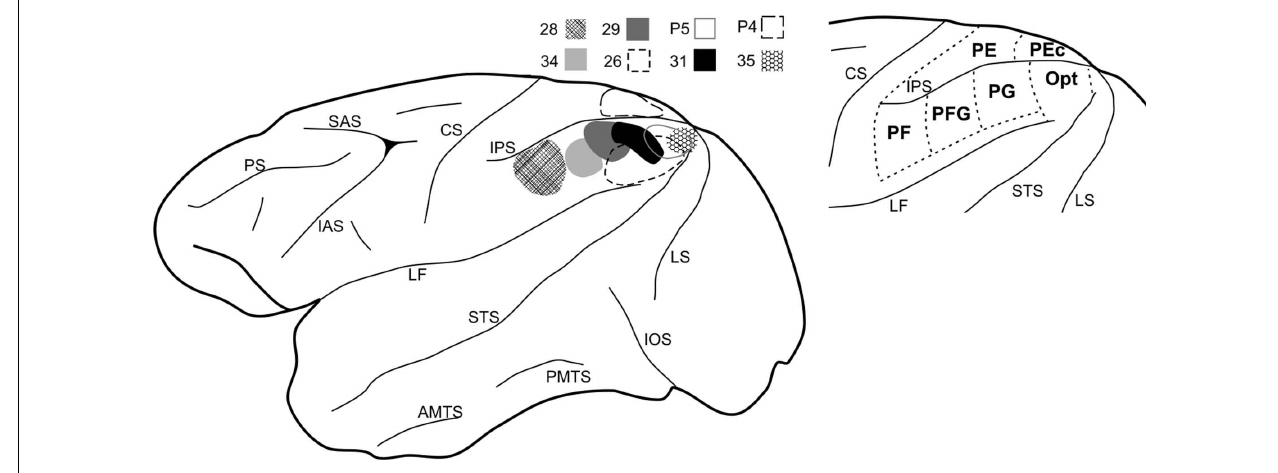
anterior middle temporal sulcus; CS, central sulcus; IAS, inferior arcuate sulcus; IOS, inferior occipital sulcus; IPS, intraparietal sulcus; LF, lateral fissure; LS, lunate sulcus; PMTS, posterior middle temporal sulcus; PS, principal sulcus; SAS, superior arcuate sulcus; STS, superior temporal sulcus.